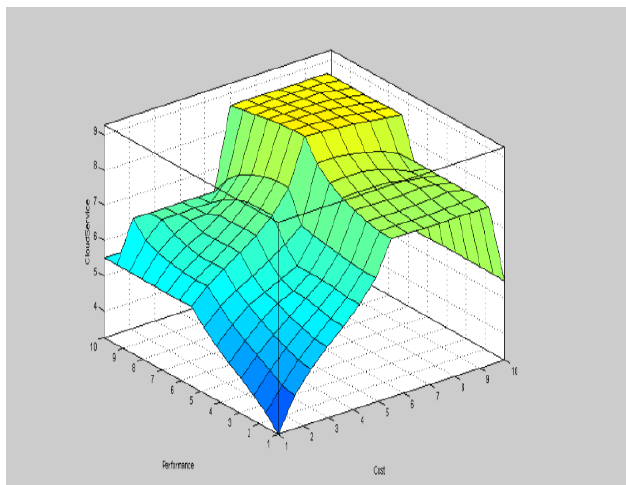
Figure 5. Surface Viewer of Proposed AFIS Table 11. Cloud Service and Ranking of Proposed